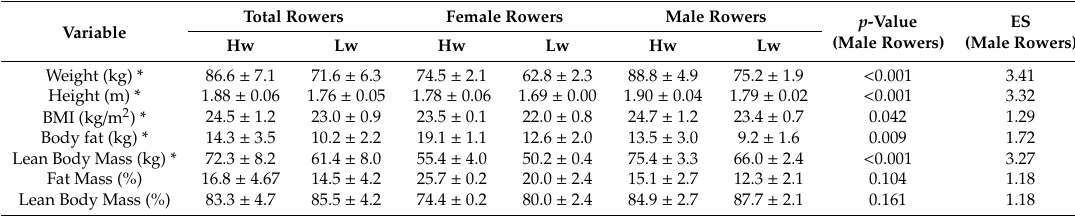
Table 1. Age and anthropometric variables in heavyweight and lightweight rowers divided by sex. Data are presented as M ± SD.